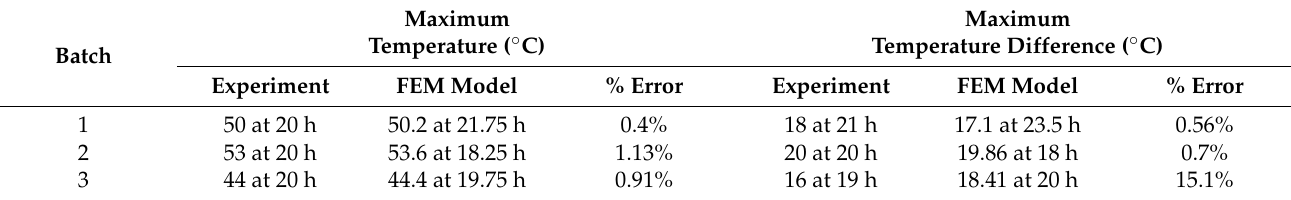
Figure 16. Comparison between FEM model prediction and measured temperatures for Batch 3. Table 6. Percent difference for maximum temperature and temperature